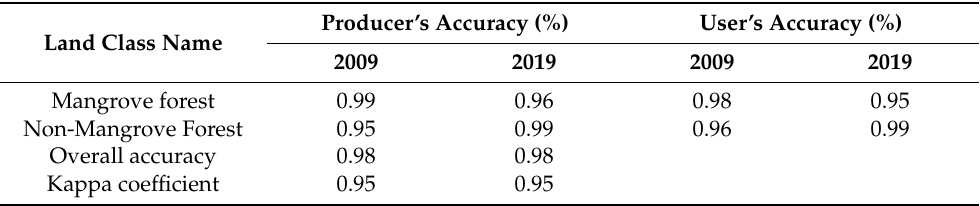
Table 2. Accuracy assessment from Random Forest classification 2009 and 2019 Landsat decadal time series analysis (Bowen to Shoalwater and Corio Bays Area Ramsar Wetland, Central